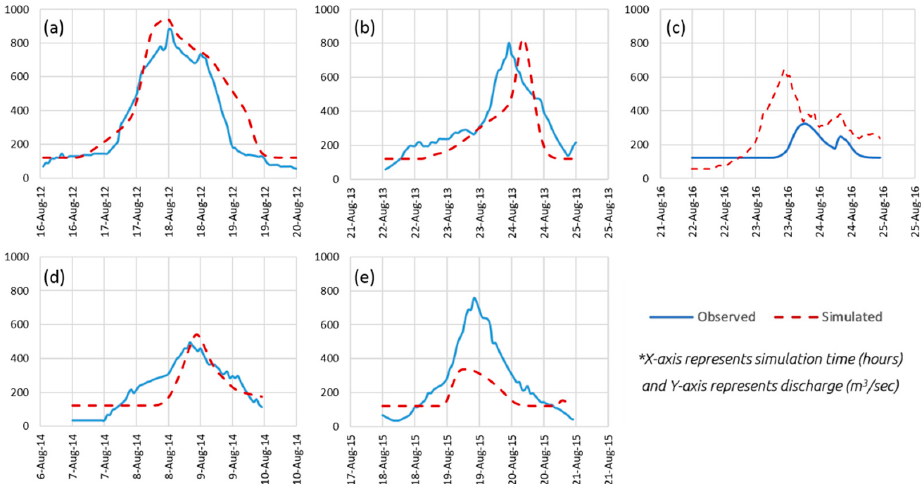
Figure 7. Model calibration and validation results: hydrographs of storm events after calibration in ( a ) 2012, ( b ) 2013, and ( c ) 2016; and validation in ( d ) 2014 and ( e ) 2015.